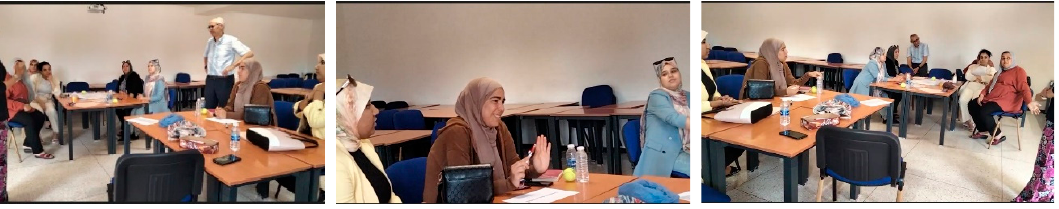
Figure 3. Pictures of the participants during the experiment.